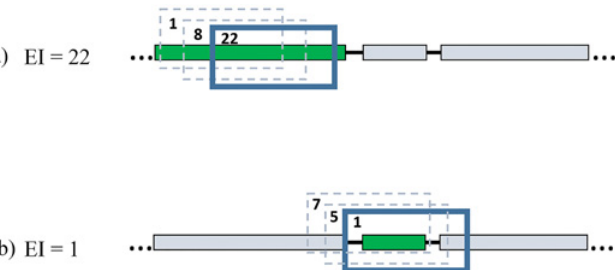
Fig 2. Diagram of EI assignation per gene. a) For a gene larger than the window size, the EI correspond to the window with the larger number of unique insertions among all windows embedded on that gene. b) For genes smaller than the window size, EI is the smallest insertion count among all windows that fully encompass the specific gene. 20% of the 3 0 end and 5% of the 5 0 end of every gene is truncated. Green rectangles represent the target gene, gray rectangles represent surrounding genes. Blue boxes represent the selected sliding window for determining the EI of the target gene; dashed blue boxes represent other sliding windows for the target gene. Numbers in the corner of the boxes represent the number of reads per